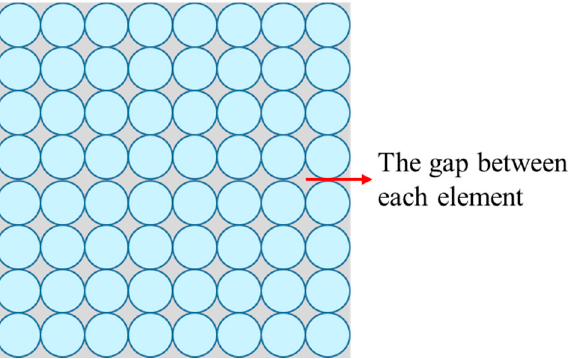
Figure 4. Schematic diagram of the gap between each element in microlens array, digital micro- mirror, and optical fiber bundle.